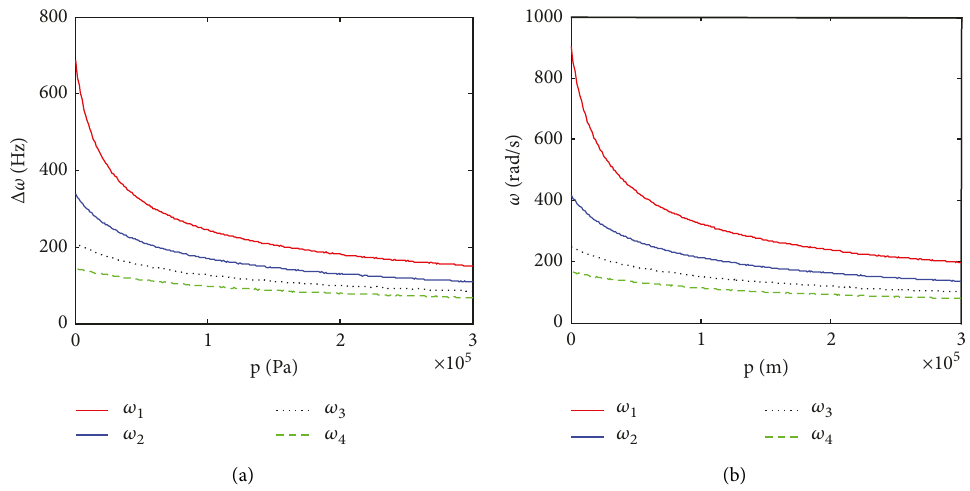
Figure 12: Changes of the resonant frequency differences with pressure (a) odd modes (b) even modes.